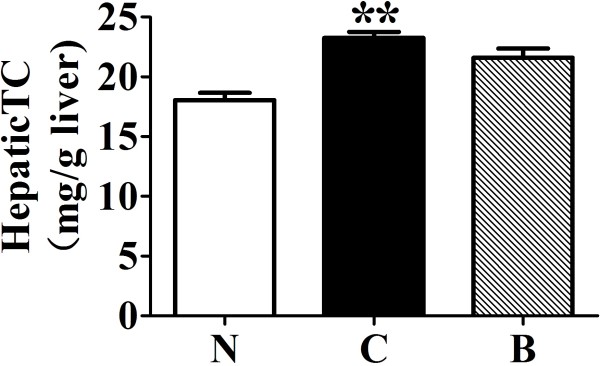
Effects of berberine (BBR) on hepatic total cholesterol. N, Normal control; C, vehicle –treated rats fed with HFD; B, rats with berberine treatment (200 mg/kg/d). Values are mean ± SEM. Significance was assessed by one-way ANOVA followed by Tukey's Multiple Comparison test. Data are mean ± SEM. *p < 0.05, **p < 0.01 vs N.